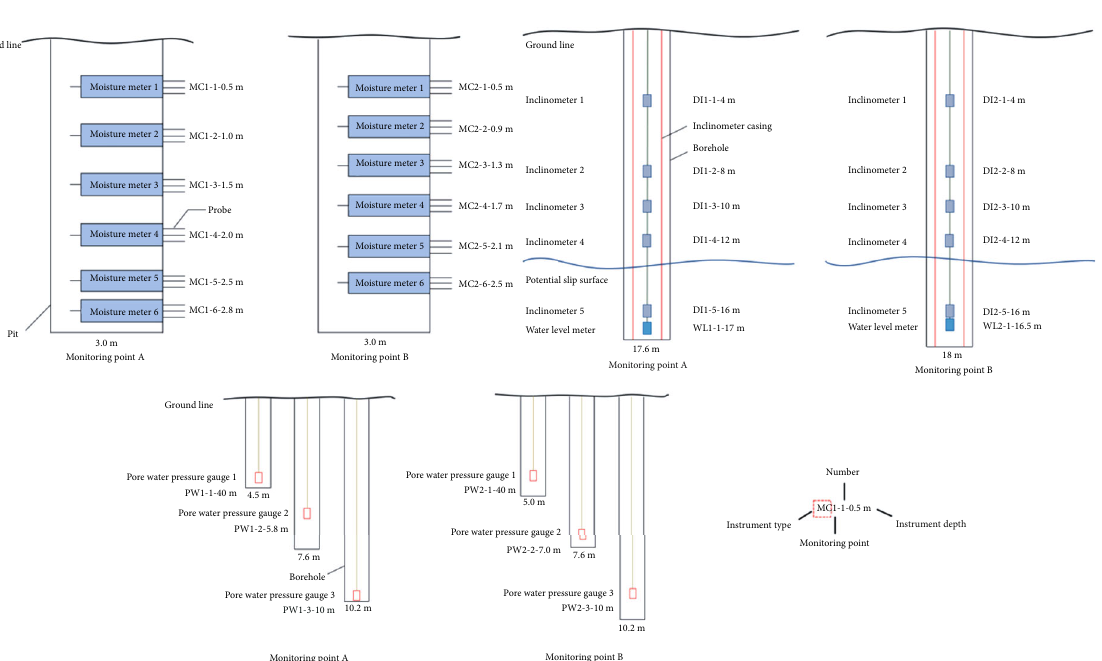
Figure 5: Sections of instrument layout at monitoring points.